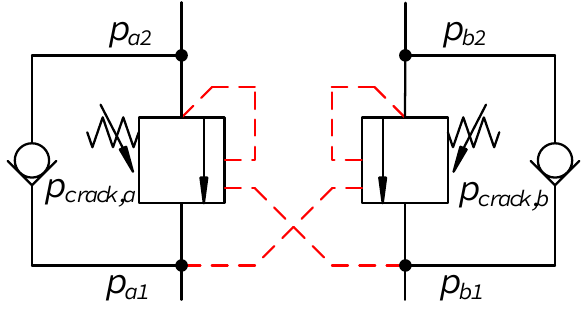
Figure 12. Double counterbalance